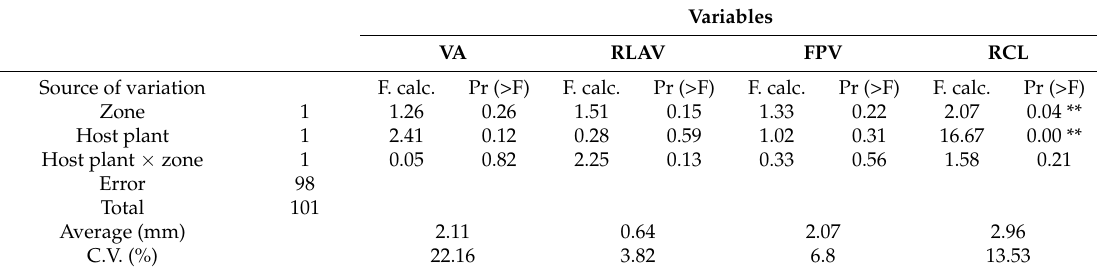
Table 2. ANOVA test for the descriptive variables of the male genitalia of N. elegantalis collected in two hosts ( S. quitoense and S. betaceum ) and two zones (Western Andes and Eastern Andes). Variables VA RLAV FPV RCL Source of variation F. calc. Pr (>F) F. calc. Pr (>F) F. calc. Pr (>F) F. calc. Pr (>F)